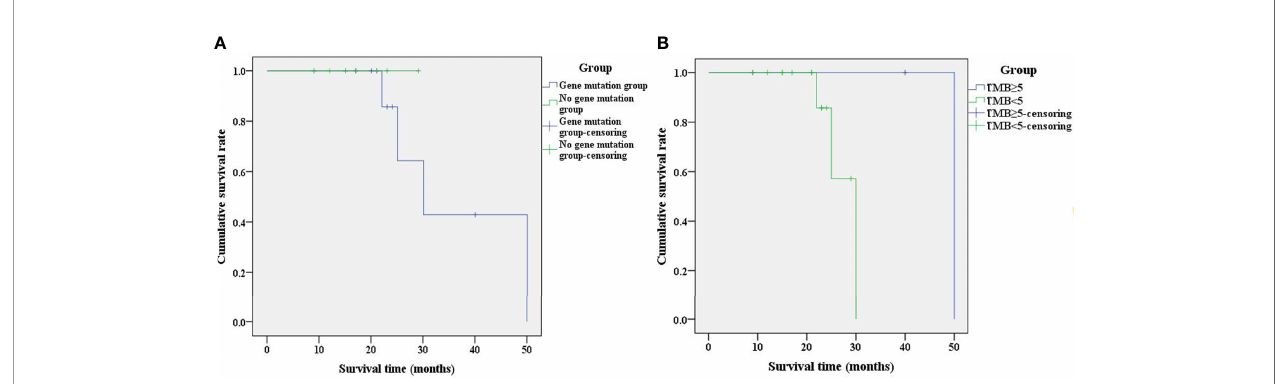
FIGURE 3 | Analysis of prognostic survival curves corresponding to different patient groups. (A) Survival curves between the gene abnormality group and the non- reported disease-related gene abnormality group; (B) Survival curves of different groups of TMB. The group-censoring represents the cases that did not survive. TMB, tumor mutation burden.